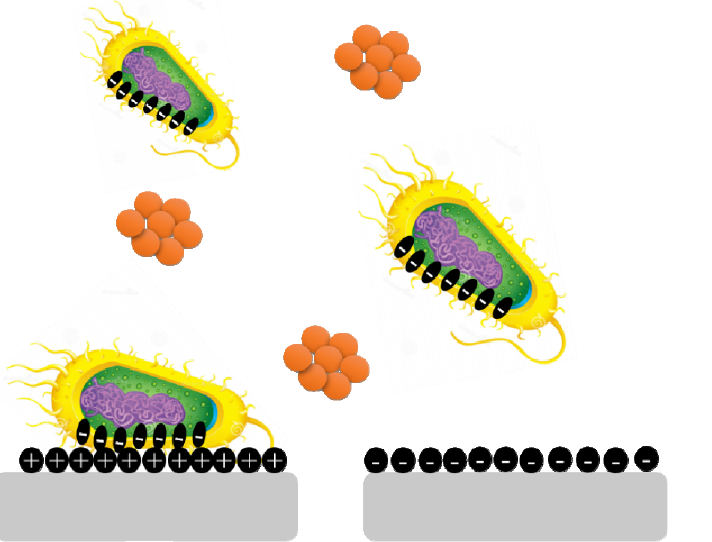
Figure 4. Schematic illustration of different existing properties of surface or biofilm formation.